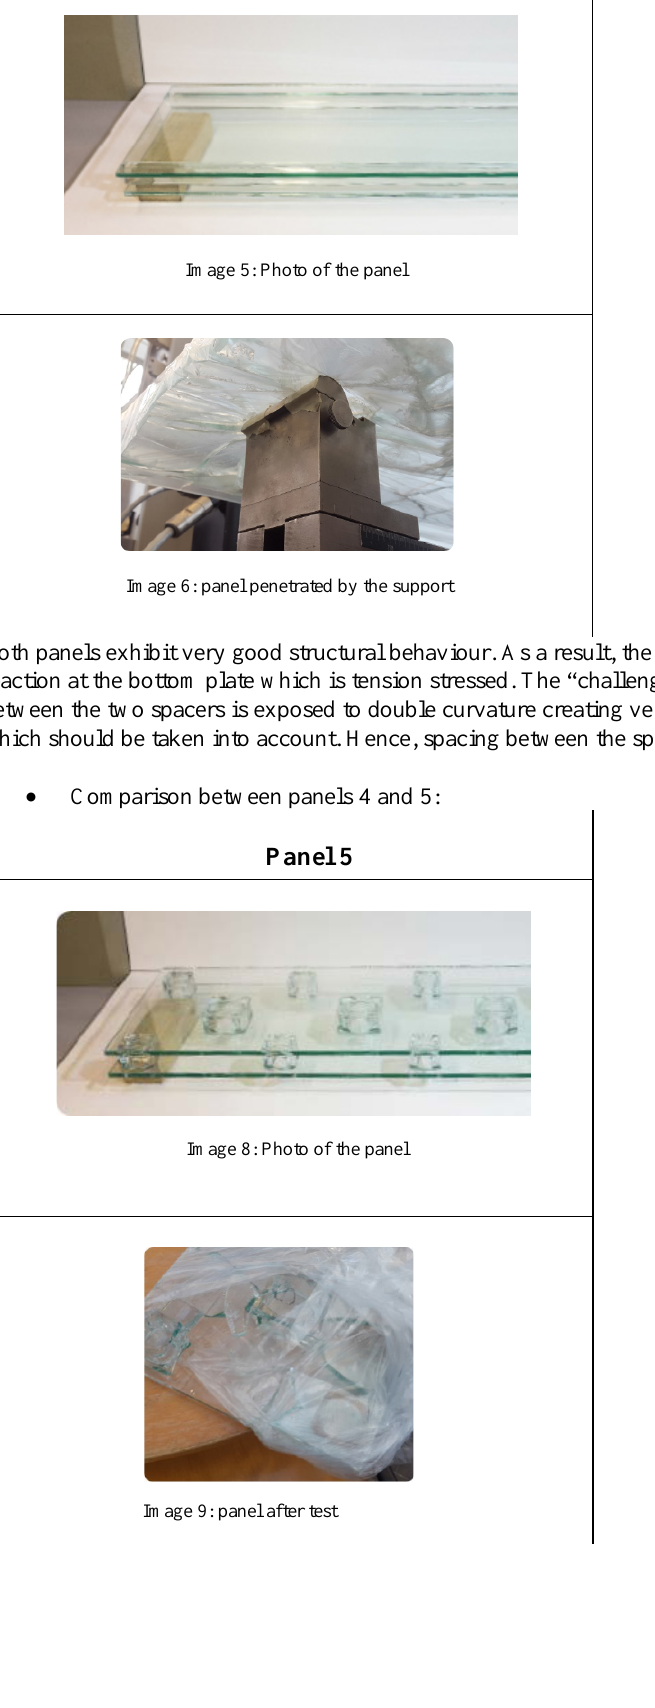
Image 5: Photo of the panel